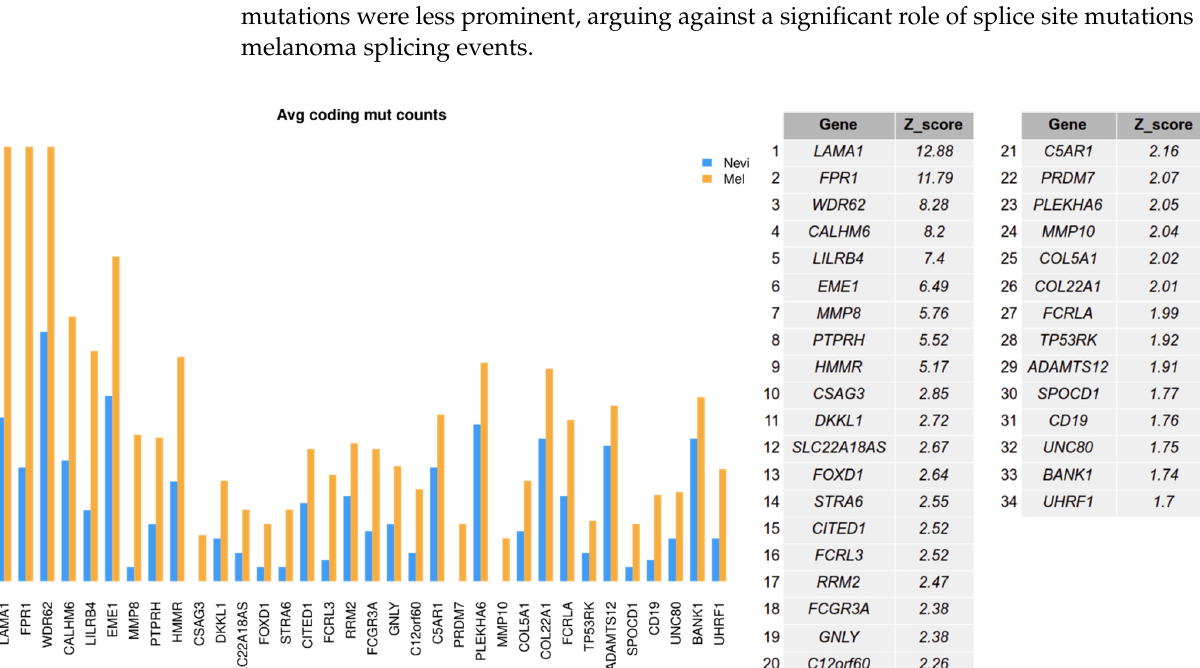
Figure 7. Number of coding mutations by gene in melanomas compared to benign melanocytic nevi. A mutation analysis was performed from the basic set of samples sequenced by RNA-seq for coding regions of genes. Only mutated genes of switched isoforms above a significance score (Z-score) of 1.6 with a 90% confidence interval are shown.